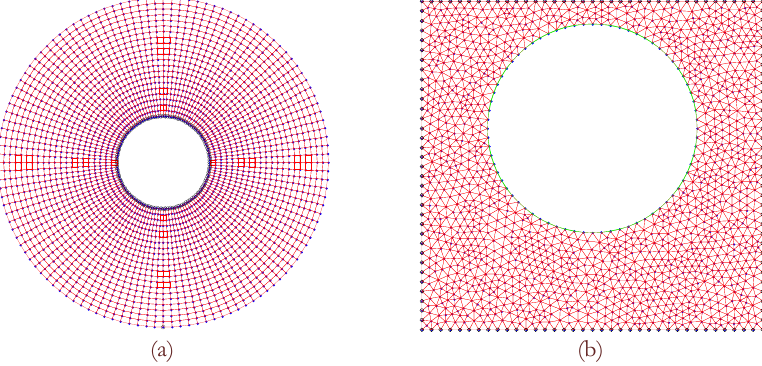
Figure 5: Finite element model of (a) shaft and (b) housing